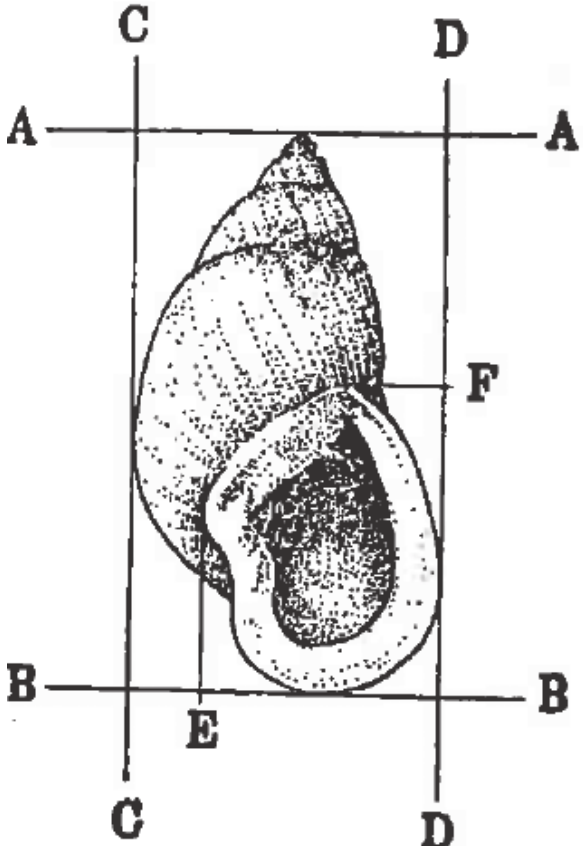
Figure 1. Crampton’s engraving of the Partula shell, overlayed with his measuring